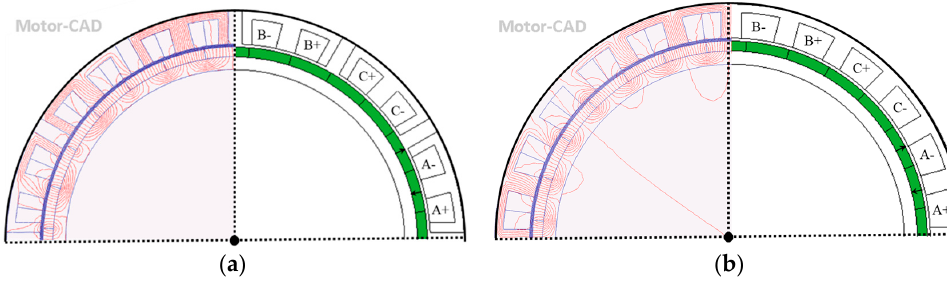
Figure 1. Cross-sections and open-circuit flux line distribution of SPM machines. ( a ) Modular machine and ( b ) non-modular machine.